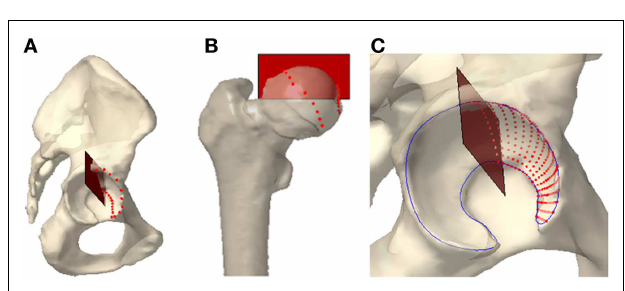
FIGURE 1 |The hip joint coordinate frame with the X (red),Y (green), and Z (blue) axes pointing from left to right, posterior to anterior, and inferior to superior, respectively .